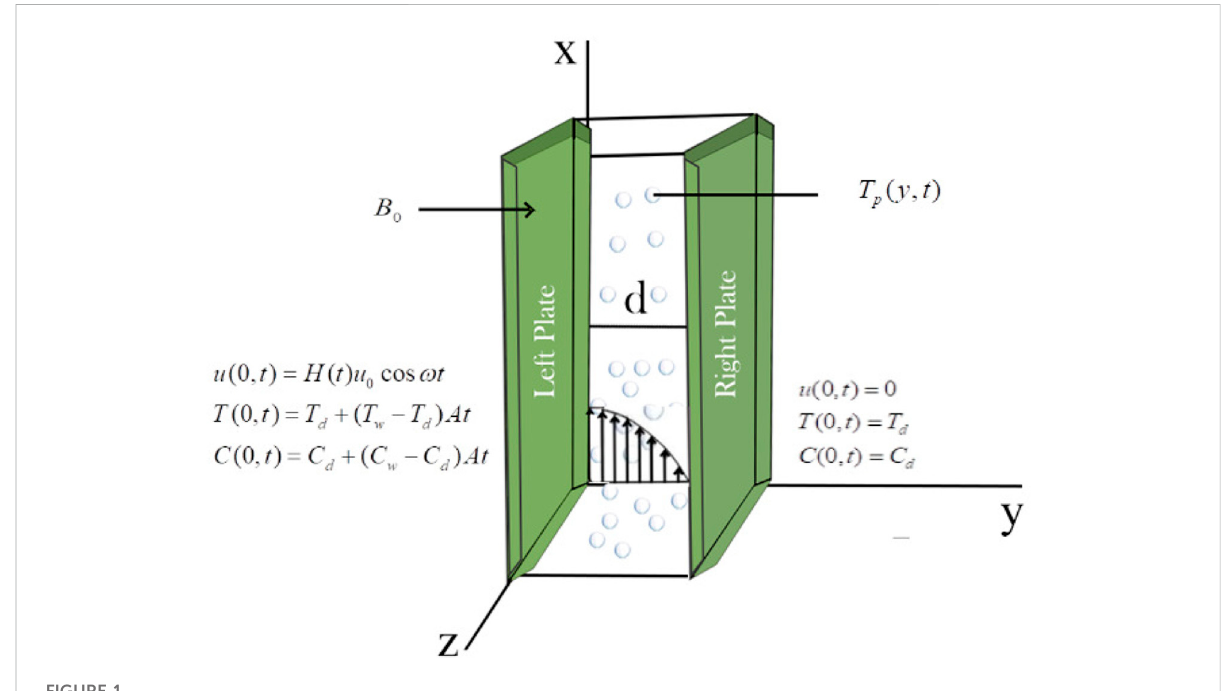
FIGURE 1 The Schematic diagram of the fl